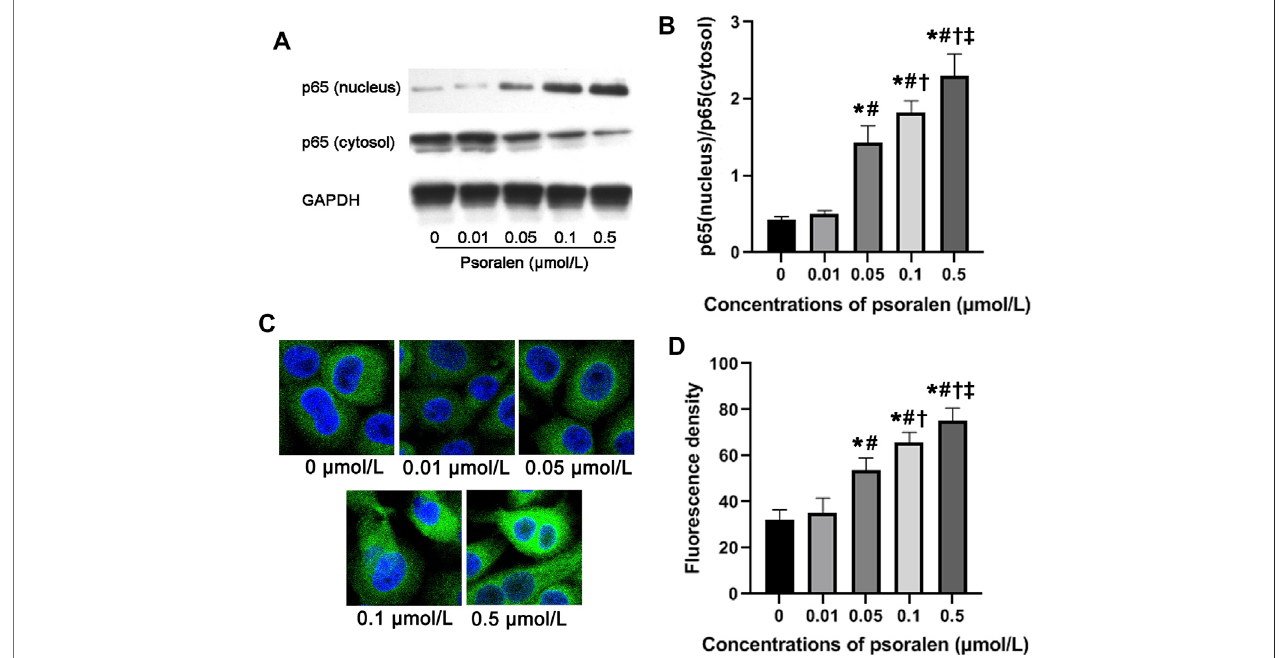
FIGURE 4 | Psoralen promotes NF- κ B activity of HTR-8/SVneo cells. (A) Representative images of Western blot. (B) Relative protein level of NF- κ B p65 protein in HTR-8/SVneo cells after exposure to different concentrations (0, 0.01, 0.05, 0.1, and 0.5 μ mol/L) of psoralen for 48 h. (C) Representative images of immuno fl uorescence staining. (D) Fluorescence intensity of p65 in nuclei of HTR-8/SVneo cells after exposure to different concentrations (0, 0.01, 0.05, 0.1, and 0.5 μ mol/L) of psoralen for 48 h. Values are mean ± SD. Experiments were performed in triplicate and repeated three times. * p < 0.05 vs. 0 μ mol/L; # p < 0.05 vs. 0.01 μ mol/L; † p < 0.05 vs. 0.05 μ mol/L; ‡ p < 0.05 vs. 0.1 μ